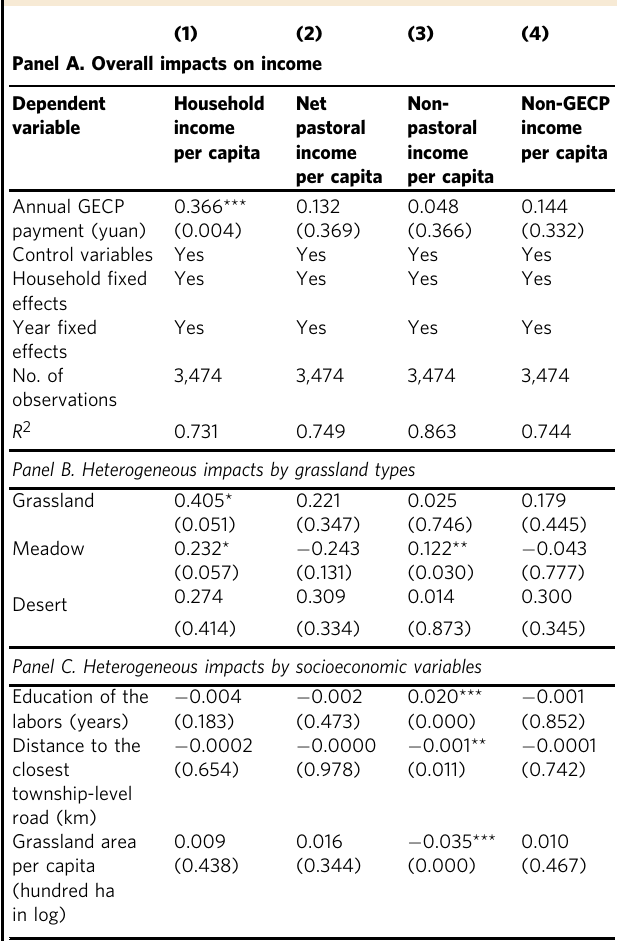
Table 3 Estimated impacts of the Grassland Ecological Compensation Program (GECP) payment on income equity: household level, fi xed-effect (FE) model.